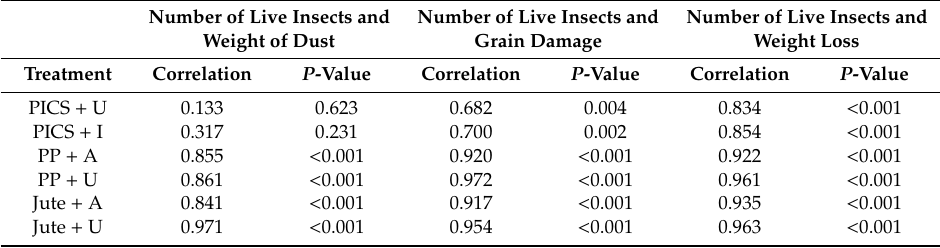
Table 6. Correlations between: (i) live insects and weight of dust; (ii) live insects and weight of dust; and (iii) number of live insects and grain damage. Number of Live Insects and Number of Live Insects and Number of Live Insects and Weight of Dust Grain Damage Weight Loss Treatment Correlation P -Value Correlation P -Value Correlation P -Value PICS + U 0.133 0.623 0.682 0.004 0.834 < 0.001 PICS + I 0.317 0.231 0.700 0.002 0.854 < 0.001 0.855 0.920 < 0.001 0.922 < 0.001 PP + U 0.861 < 0.001 0.972 < 0.001 0.961 < 0.001 Jute + A 0.841 < 0.001 0.917 < 0.001 < 0.001 Jute + U <